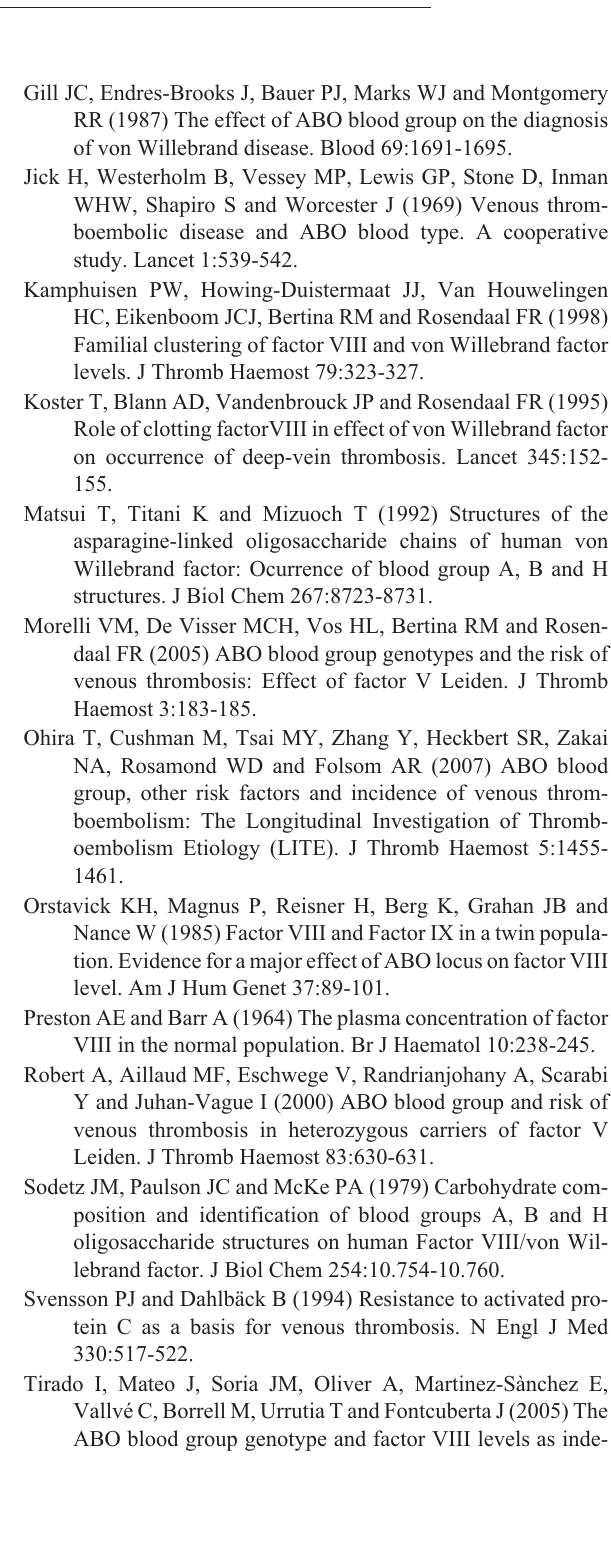
Ohira et al. (2007) OR = odds ratio, *FVL